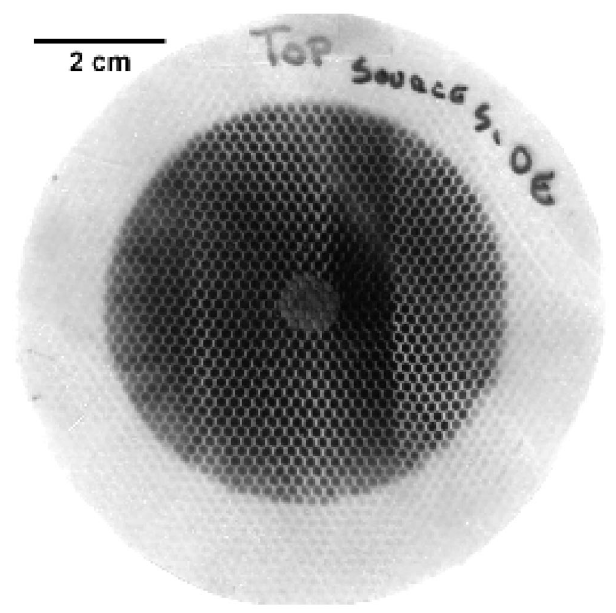
FIG. 10. Kapton image of beam exiting the diode. The regular patterns superimposed on the image are due to the honeycomb shielding